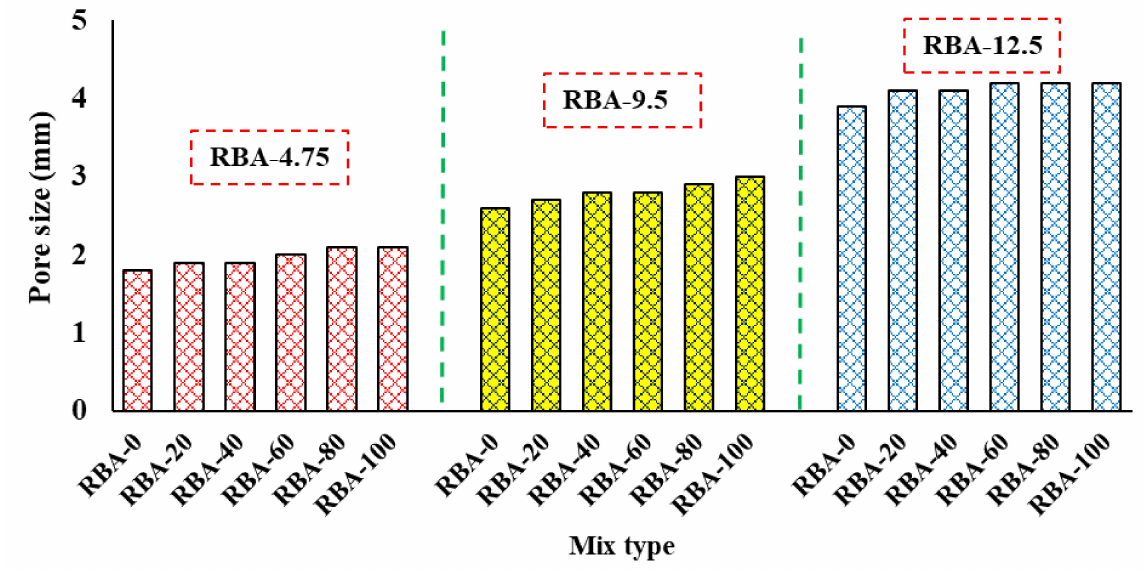
Figure 10. Average pore sizes for different